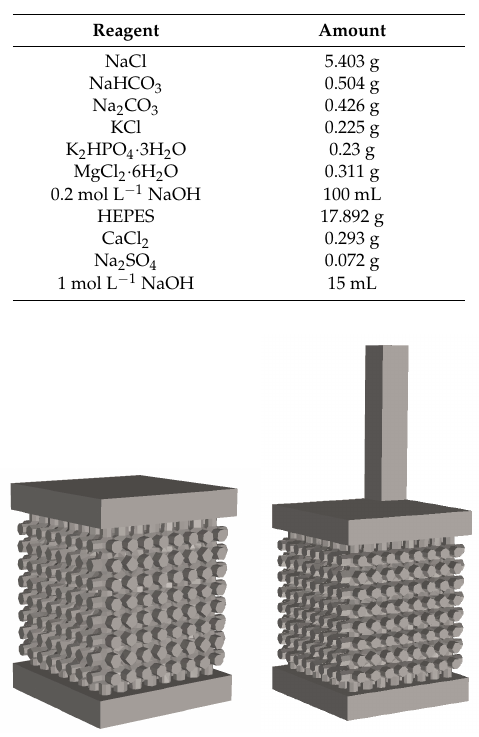
Figure 1 . CAD files of the immersion and electrochemical samples.